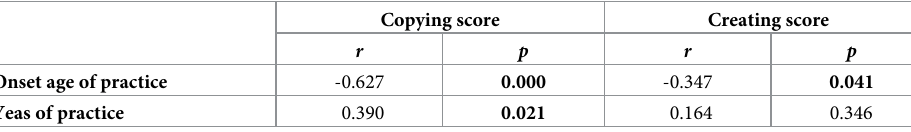
Table 1. The relationship between the time factors of CCH practice and calligraphy